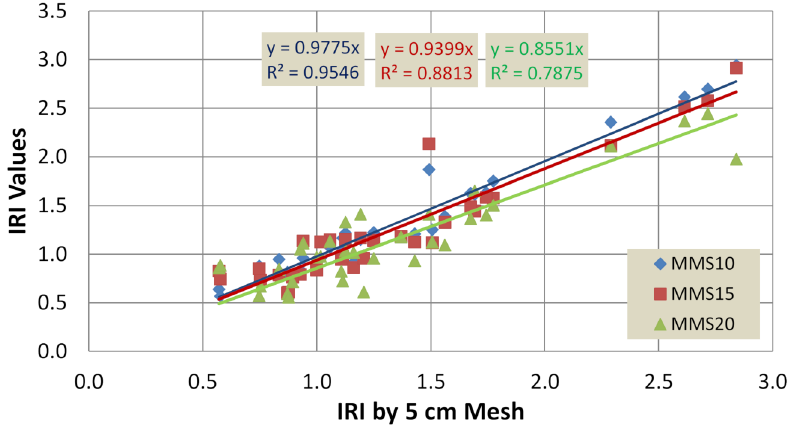
Figure 15. Comparison of the measured IRI using different mesh sizes with the measured IRI using a mesh size of 5 cm × 5 cm.